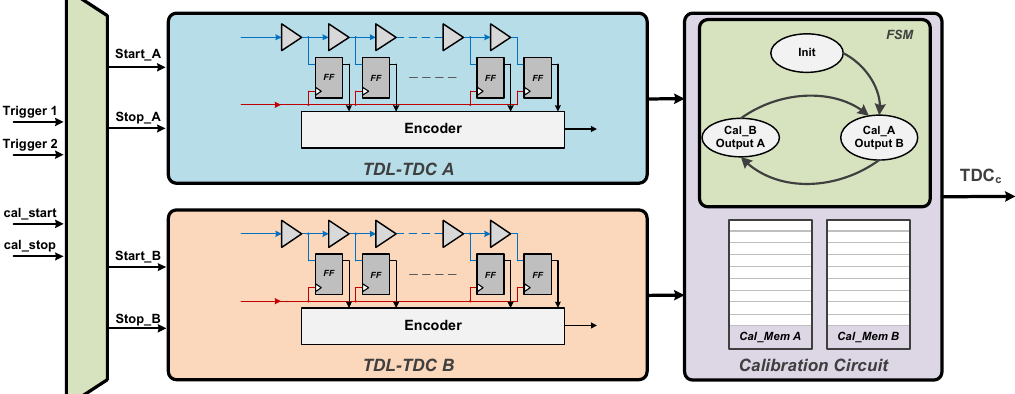
Figure 3. Architecture of